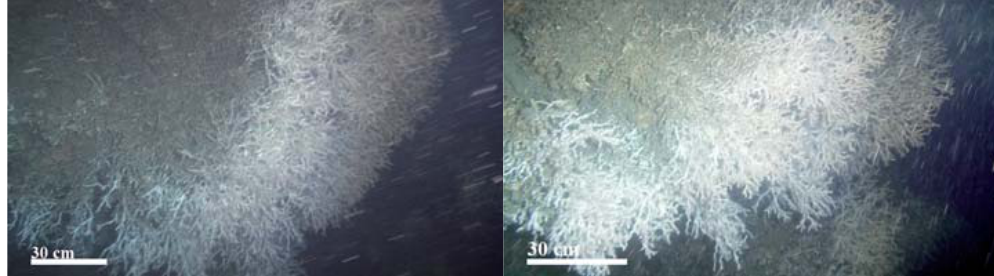
Fig. 5. Massive coral framework structure observed on a vertical rocky wall with outcrops on the southern flank of the Lacaze-Duthiers Canyon (LDC, T16) at 320–330m depth, faced to 10–40 ◦ heading, and with an estimated length of approximately 20m. This framework was mainly composed of live Lophelia pertusa , with presence of some Madrepora oculata colonies.